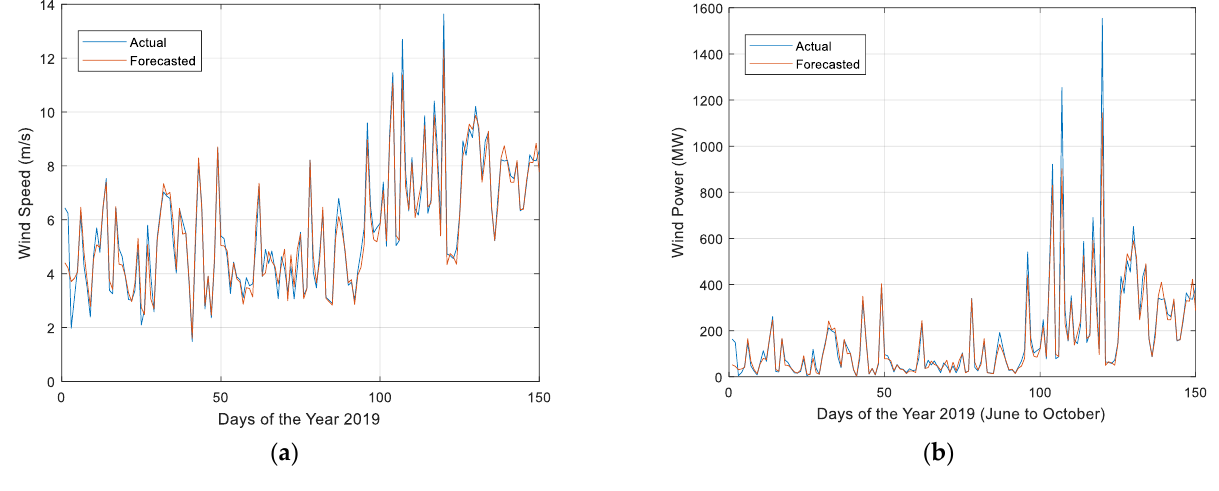
Figure 9. ( a ) Comparative analysis of wind speed forecasting by the FFNN trained through HPSOBA. ( b ) Comparative analysis of wind power forecasting by the FFNN trained through HPSOBA.